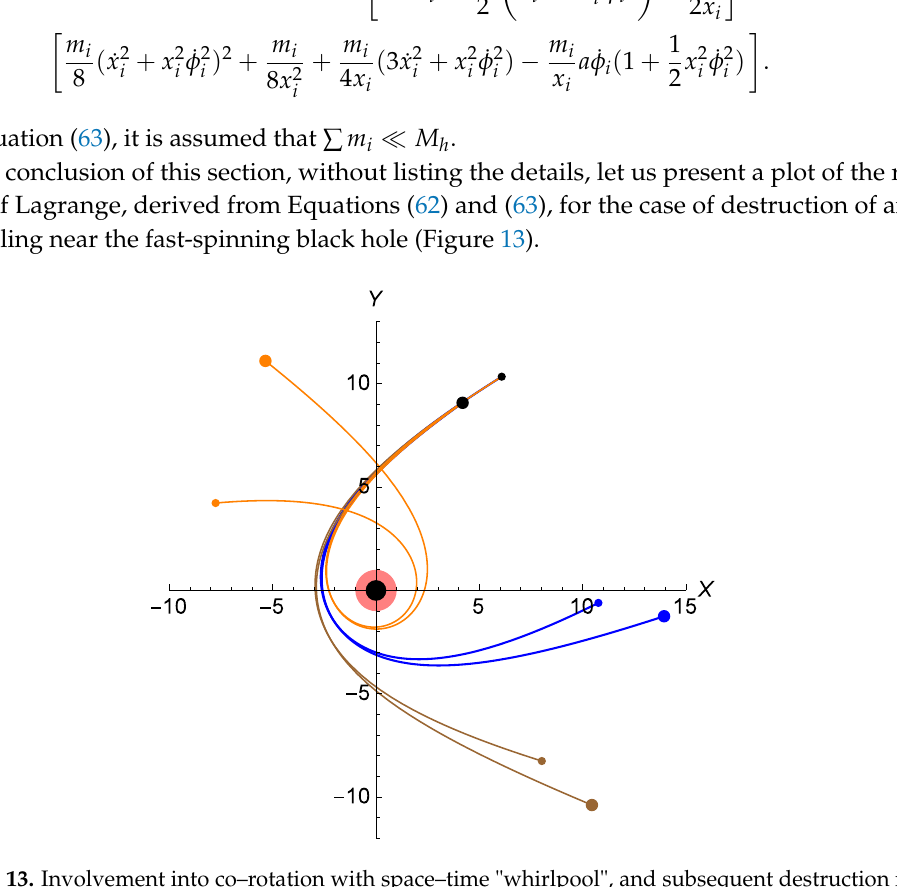
Figure 13. Involvement into co–rotation with space–time "whirlpool", and subsequent destruction into two fragments, of an elastic body traveling in the vicinity of a black hole. Three black hole rotation regimes are shown: for non-rotating black holes ( a = 0, blue), and for quickly rotating black holes with parameter a → − 0.5 (orange) and a → + 0.5